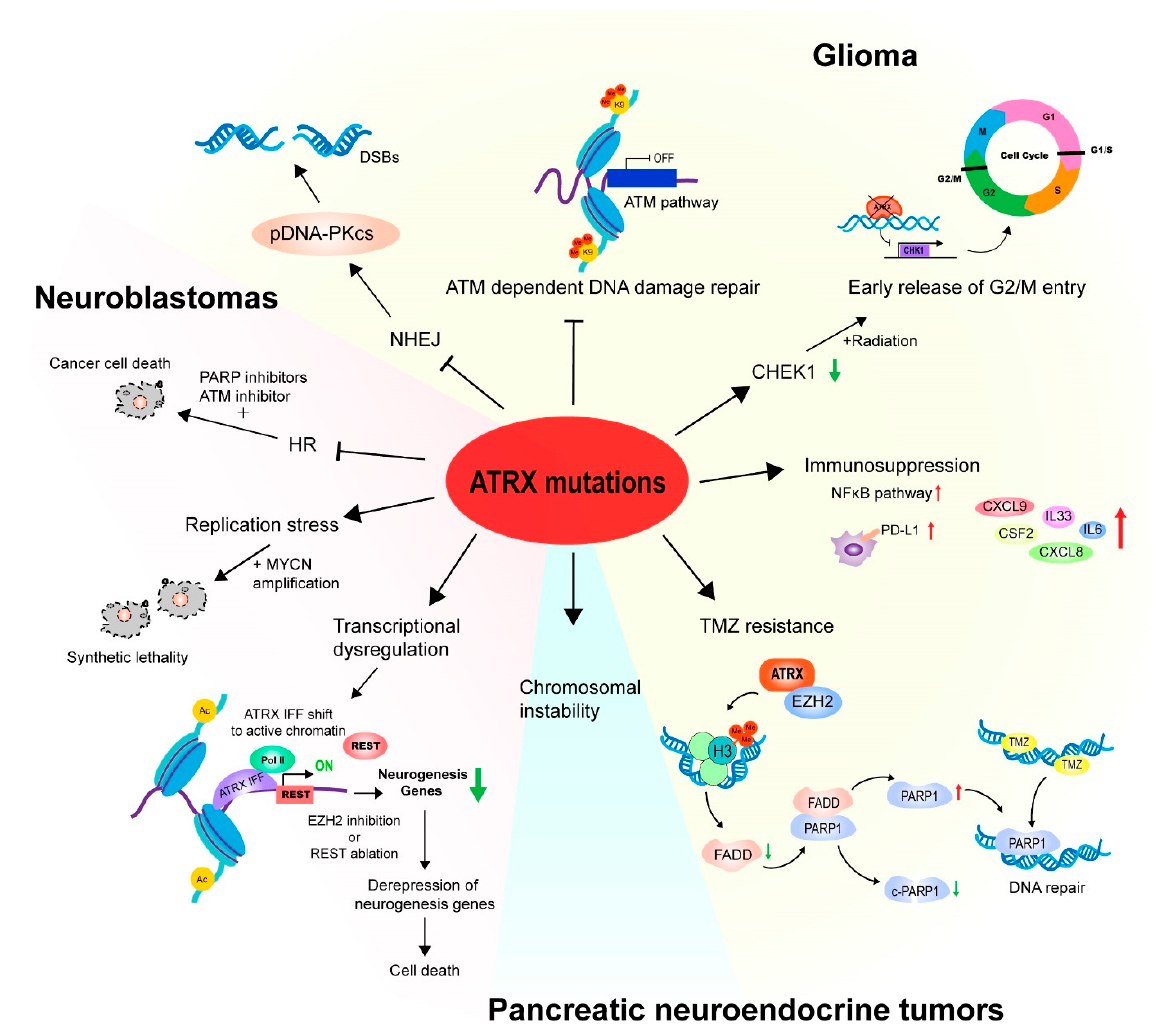
Figure 5. ATRX mutations and cancers. In gliomas, ATRX mutations impair NHEJ and ATM-dependent DNA damage repair pathway, down-regulate CHEK1 expression that results in the early release of G2/M entry, induce immunosuppression, and participate in TMZ resistance. In neuroblas- tomas, ATRX mutations impaired DNA damage repair through HR, cause synthetic lethality with MYCN amplification, and regulate transcription through reorganization of the chromatin landscape. In pancreatic neuroendocrine tumors, ATRX mutations lead to chromosomal instability. Red arrows: up-regulate; green arrows: down-regulate. Abbreviations: HR, homologous recombination; NHEJ, non-homologous end-joining; PARP, poly (ADP-ribose) polymerase; CHEK1, Checkpoint Kinase 1; PD-L1, immune-checkpoint protein programmed death-ligand 1; TMZ, temozolomide; EZH2, enhancer of zeste homolog 2; FADD, Fas-associated death domain; ATRX IFF, ATRX in-frame fusion proteins.